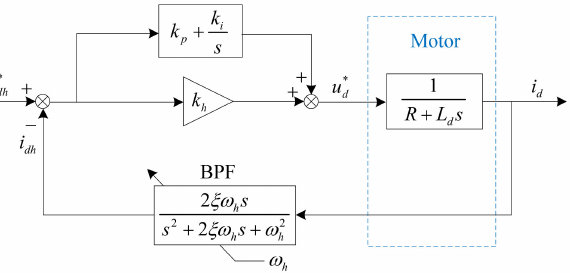
Figure 6. Enhanced current control loop considering PRFS signal injection.